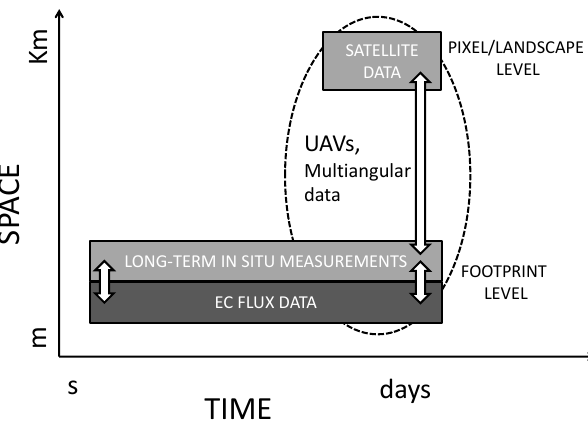
Figure 6. Upscaling of optical and flux data across space and time. While long-term in situ spectral measurements help us establish a link between optical and flux data across time, new tools like UAVs are still needed to facilitate the spatial upscaling from the footprint to the landscape